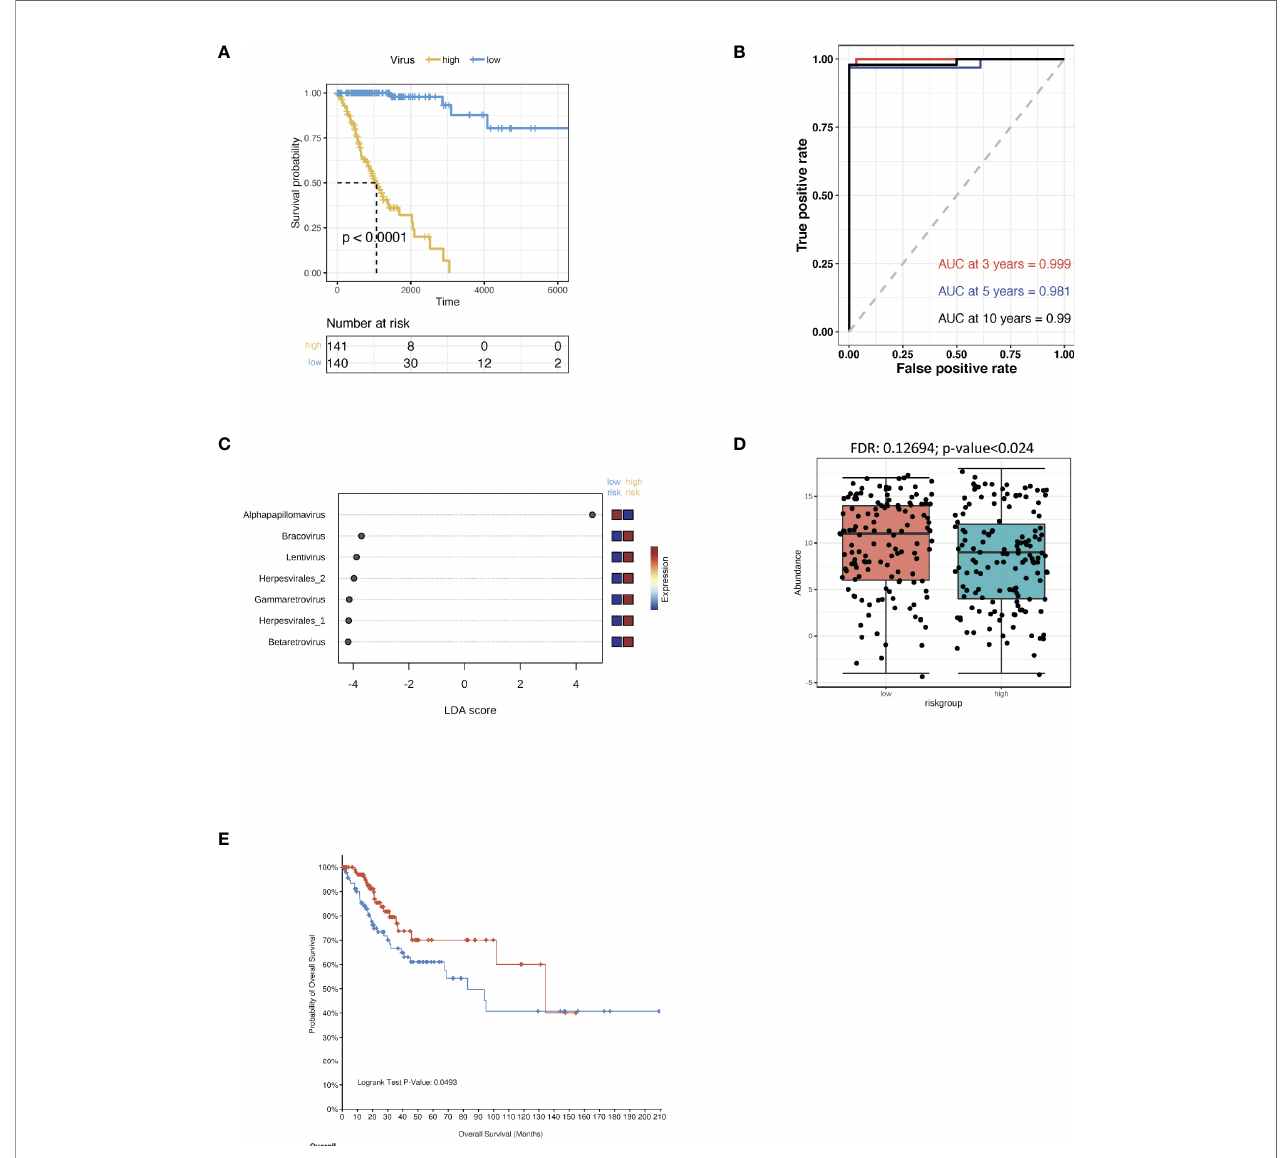
FIGURE 1 | Virus analysis of the prognosis of high and low risk groups of CSCC patients. (A) Kaplan-Meier analysis of the risk groups that were de fi ned with prognosis-correlated viruses in the TCGA dataset for CSCC patients. (B) Three-, fi ve- and ten-year ROC survival curves of the risk groups for the CSCC TCGA dataset. (C) The contribution to the classi fi cation is ranked and alpha HPV is observed to support the low-risk group. Linear discriminant analysis was used to study the degree of in fl uence of differential bacteria on sample groupings. (D) The abundance of alpha HPV in the low and high risk groups. (E) Kaplan-Meier survival analysis of the HPV + group in CSCC